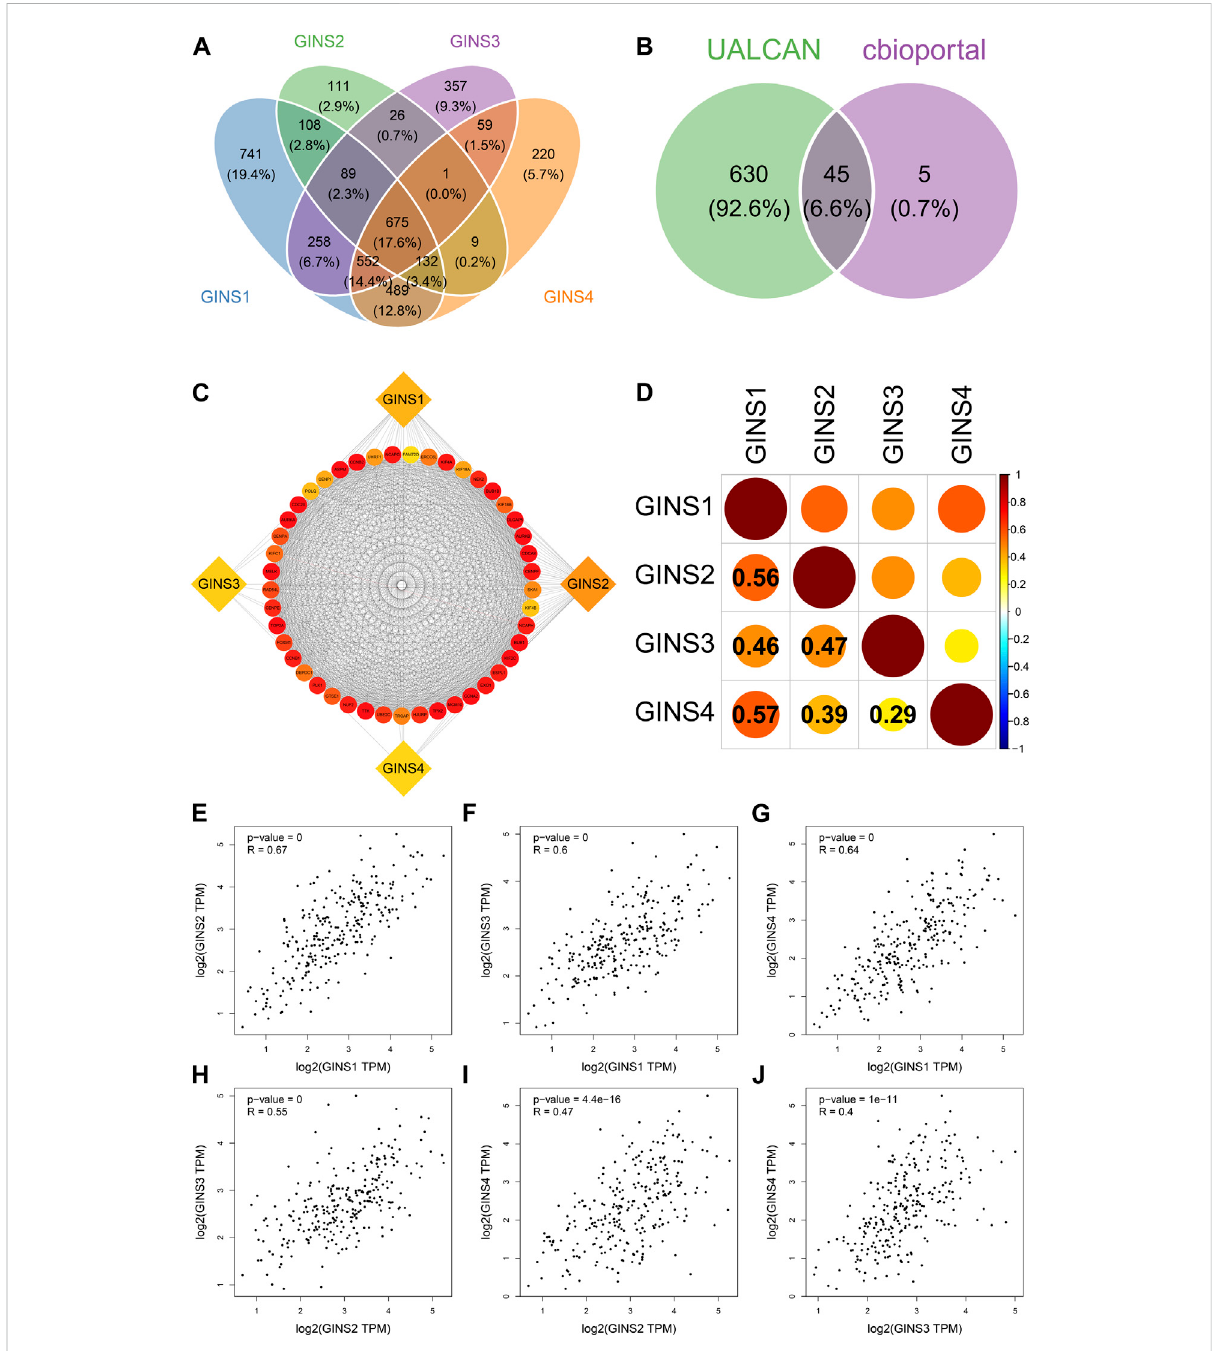
FIGURE 8 Co-expressed genes and co-expression analysis of GINS subunits in SARC. Common 675 genes among co-expressed genes of GINS1/2/3/ 4 analyzed by UALCAN (A) . 45 co-expressed genes simultaneously predicted by UALCAN and cBioPortal database (B) . The protein-protein interactionanalysisofGINS1/2/3/4and45co-expressedgenes (C) .Theco-expressionanalysisofGINS1/2/3/4inSARCfromthecBioPortaldatabase (D) . The co-expression analysis of GINS1/2/3/4 in SARC from the GEPIA database (E – J)